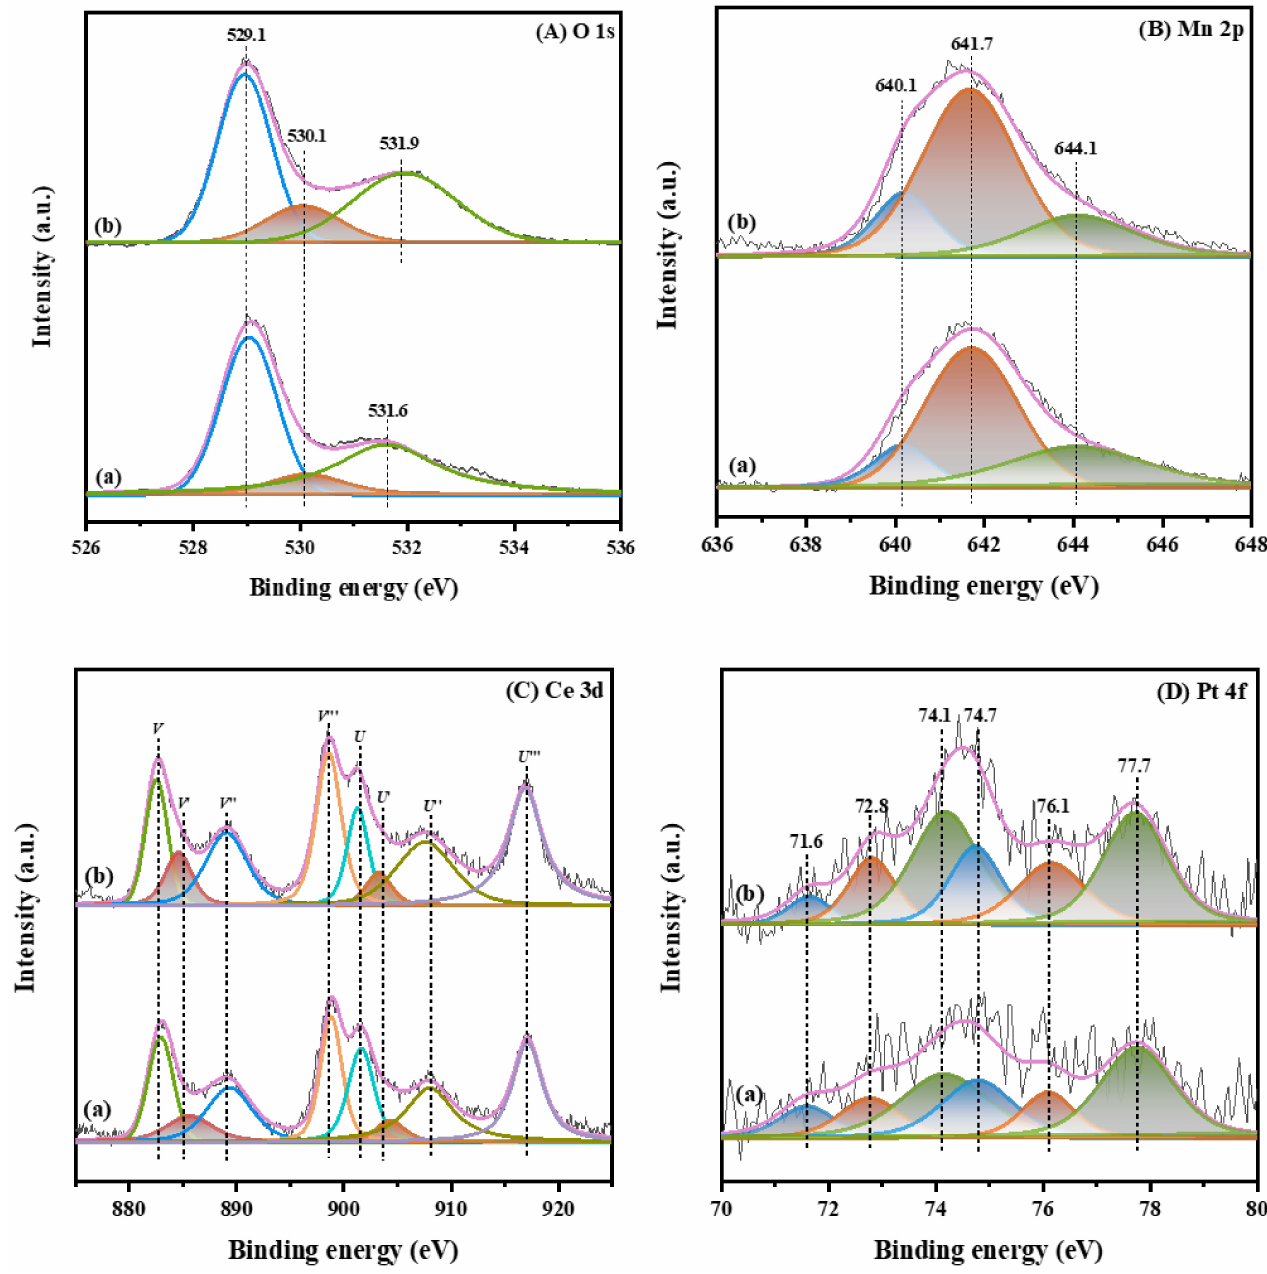
Figure 4. ( A ) O 1s, ( B ) Mn 2p, ( C ) Ce 3d, and ( D ) Pt 4f XPS spectra of (a) Pt/CeMnO x and (b) Pt/CeMnO x